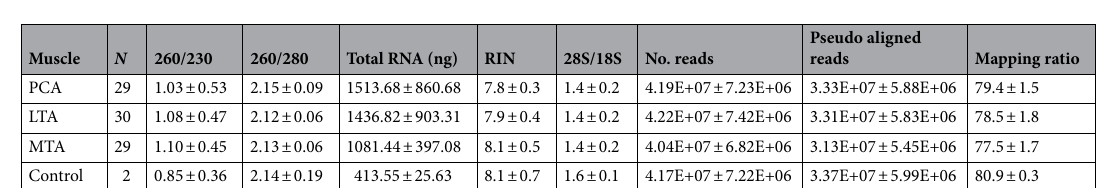
(Fig. 6). Moreover, the advantage of pooling three muscles over two is assurance the samples will qualify for downstream processing. An overview of the experimental protocol. The collective experimental techniques provided ( N = 68) RIN values from 7.0 to 8.6 (7.8 ± 0.4) with no RNA yields below 250 ng (981.28 ± 446.11, Table 1). Ultimately, the applied experimental modifications in conjunction with the Aurum Total RNA Mini kit significantly improved RNA recovery compared to other evaluated protocols (Table 1). Functional RNA extraction from rat ILMs required RNase-inhibiting reagents during surgical steps and overnight incubation for nucleic acid stabiliza- tion. High-quality RNA extracts were achieved by implementing the integrated (manual and mechanical) cell lysis strategy, establishing the ideal weight model, and adapting cryogenic disruption. Finally, pooling three ILMs permitted consistent and sufficient total RNA yields. The reproducibility of the experimental method was confirmed using P15 and P32 (~ 115 g) rats, which validated the effectiveness of the experimental conditions (Supp. Fig. S3). Table 4 summarizes RNA-Seq (NovaSeq) data analysis taken from 90 RNA samples, with RIN ranging between 7.0 to 9.3. Only six samples were between 7.0 and 7.4. The remaining 84 samples (RIN = 8.0 ± 0.4) ranged from 7.5 to 9.3. RNA-Seq diagnostics indicated that the few samples with lower RIN were still within the range according to the sequencing alignment score (Table 4). Principal component analysis and normaliza- tion factors also showed that 98% of the inter-intra-variability was maintained within the first two principal components, suggesting a reliable gene assessment (Fig. 7).